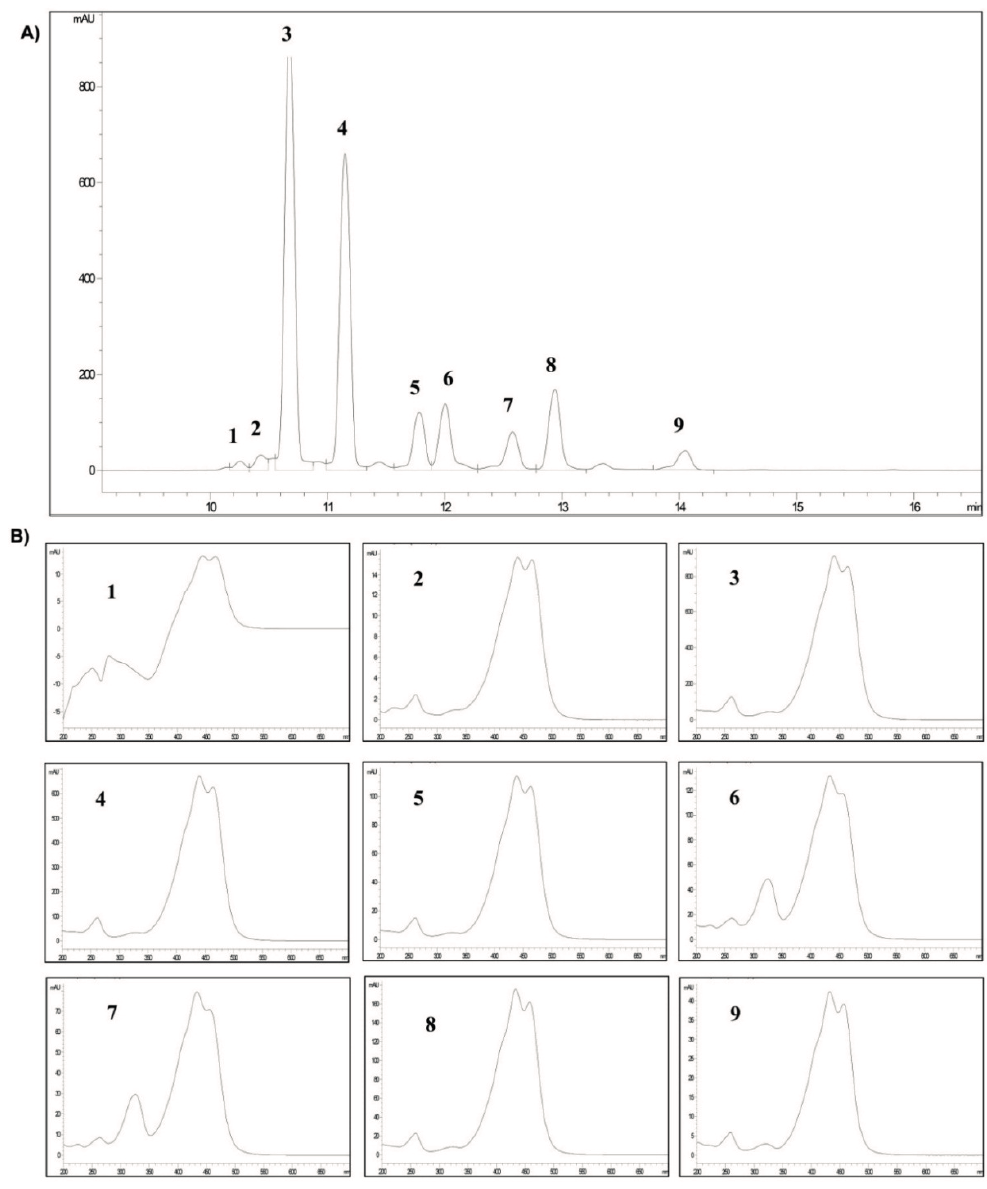
Figure 1. ( A ) Chromatogram at 440 nm of the crocetin esters pool (crocins); ( B ) UV-vis spectrum